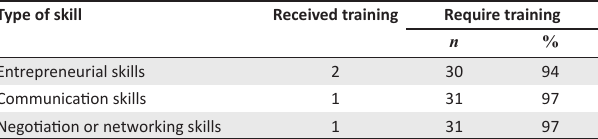
TABLE 2: Types of skills development training received and required by respondents. Type of skill